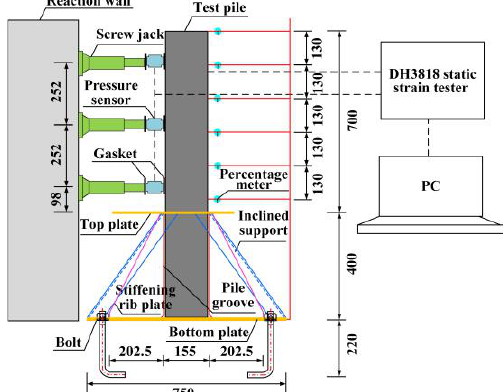
Figure 4. Diagrammatic sketch of test device (unit: mm) .